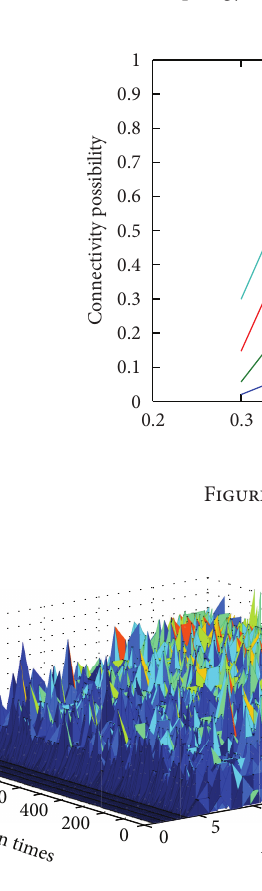
Figure 4: Different topology and its communication links in a certain area (left is random mesh; right is star).